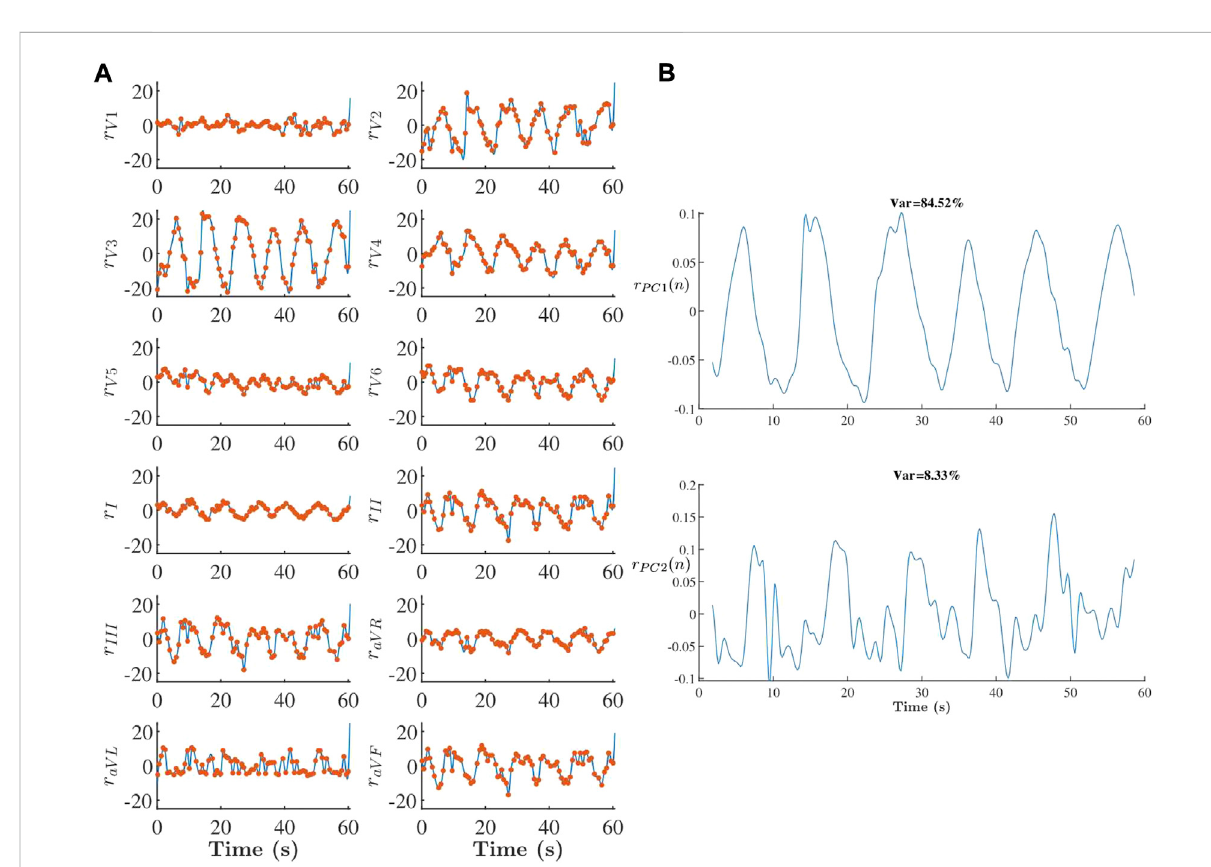
FIGURE 8 (A) Respirationsignals r l ( n )(blueline)and r l ( i )(reddots)derivedfrom1-minECGduringdeepbreathingand (B)